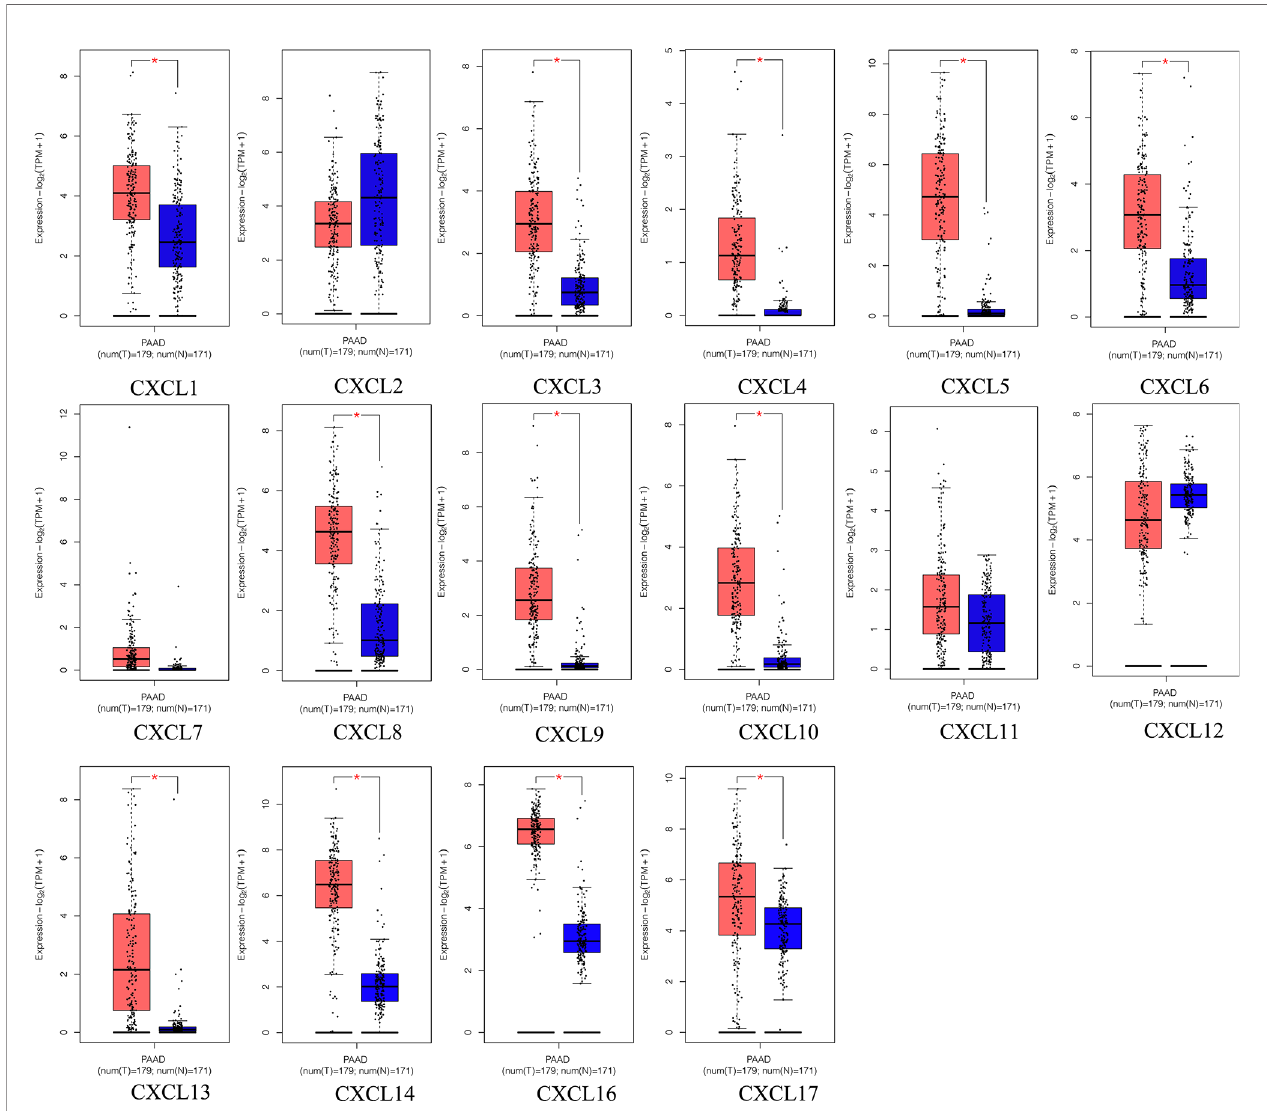
FIGURE 2 | The transcriptional levels of diverse CXC chemokine family members in PAAD tissues and adjacent pancreatic tissues (GEPIA2). PAAD tissues (red); adjacent pancreatic tissues (blue). * p < 0.01 and |Log2FC| >